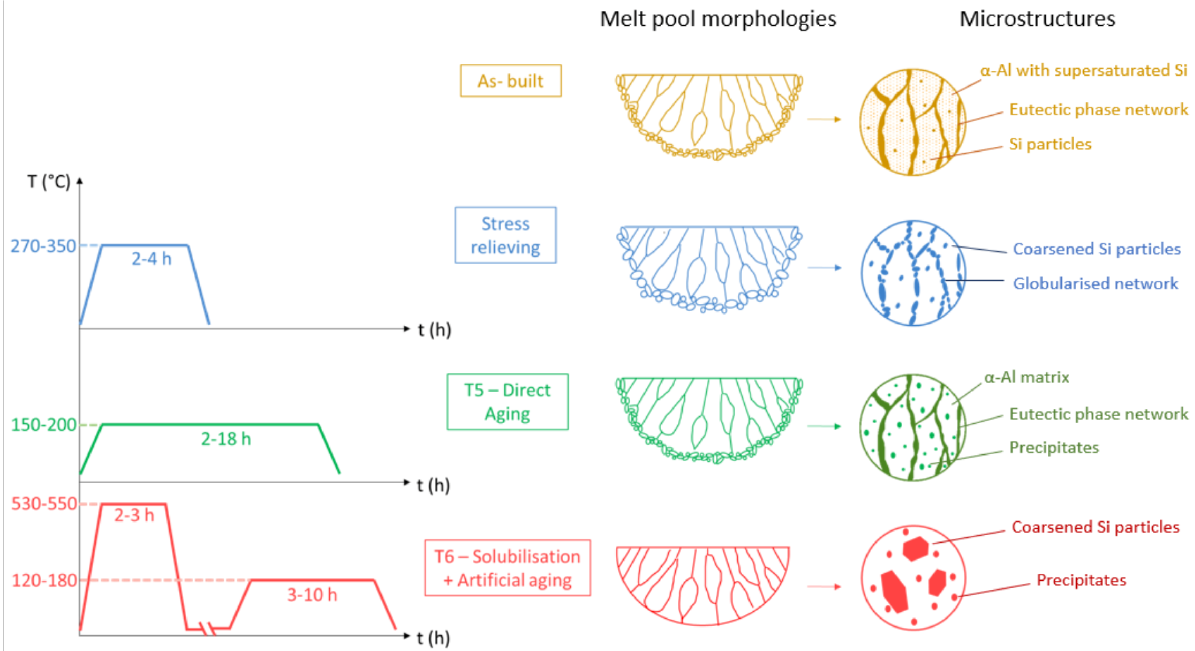
Figure 10. Thermal post-processing and its effects on melt pool morphology and microstructure in Al–Si